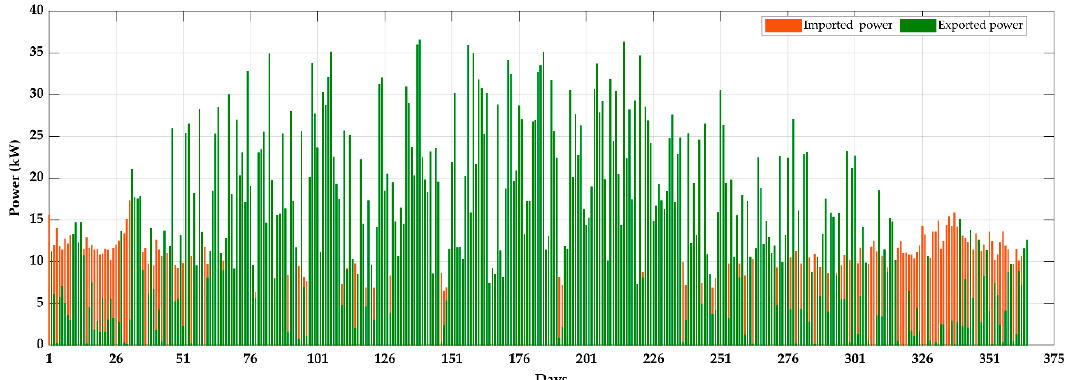
Figure 7. Imported and exported power profiles with a solar PV system and grid.